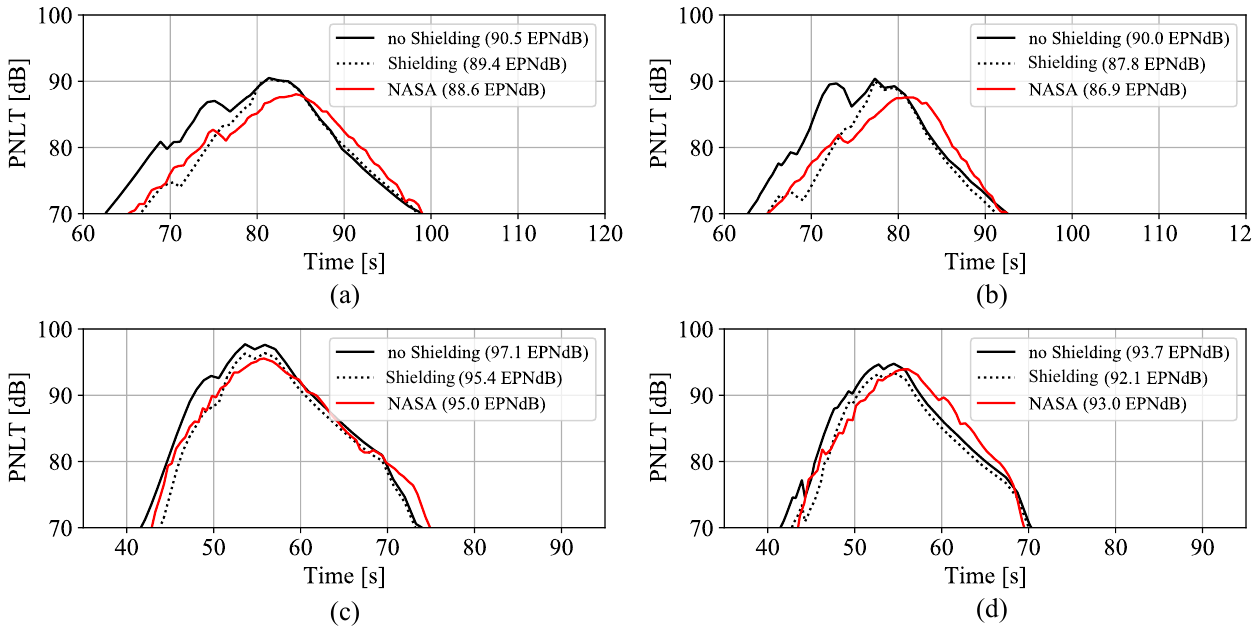
Figure 4. PNLT time history: NASA 55t STCA. Flyover measurement point for standard ( a ), advanced procedure ( b ) and lateral measurement point for standard ( c ) and advanced procedures ( d ). PANAM simulation results with engine noise shielding by using Maekawa (dotted black line), and by assuming no engine noise shielding (solid black line) as well as NASA data (solid red line) are